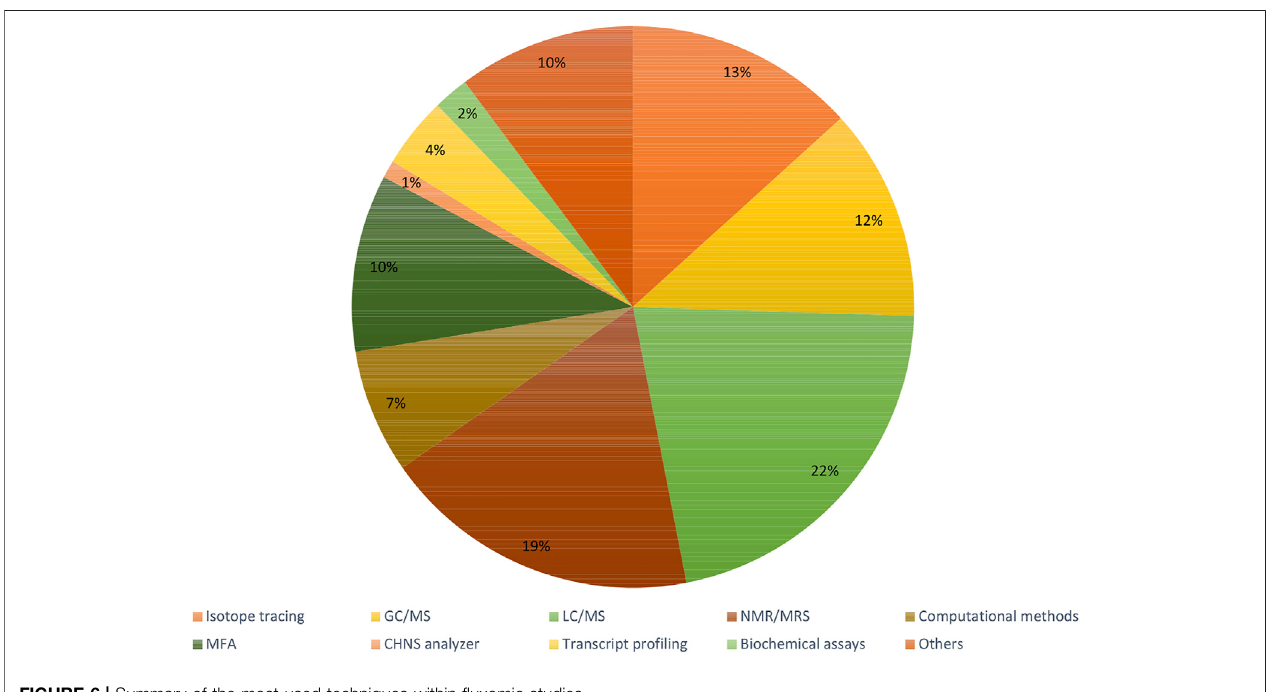
FIGURE 6 | Summary of the most used techniques within fl uxomic studies.